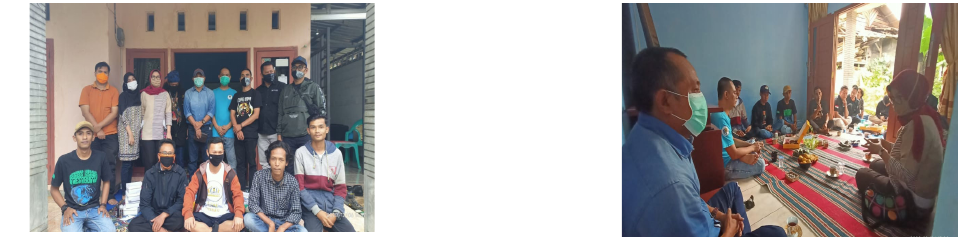
Fig. 9. One of the activities of enhancement of SABA WARGA program